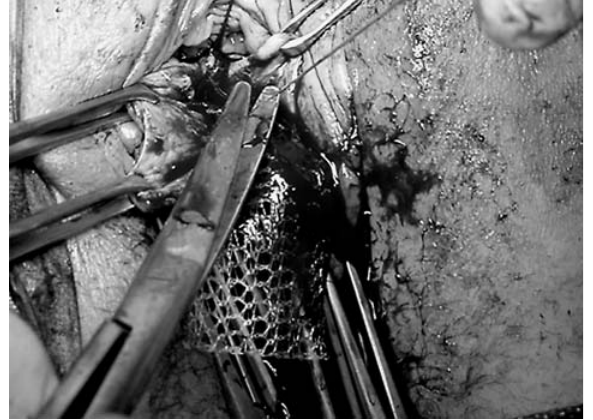
Figure 2 – Surgical technique of cistocele repair with mesh. Tension free placement of mesh with 4 suture stitches of polypro- pylene 3/0 on each edge, which are attached to the same recto- vaginal fascia previously